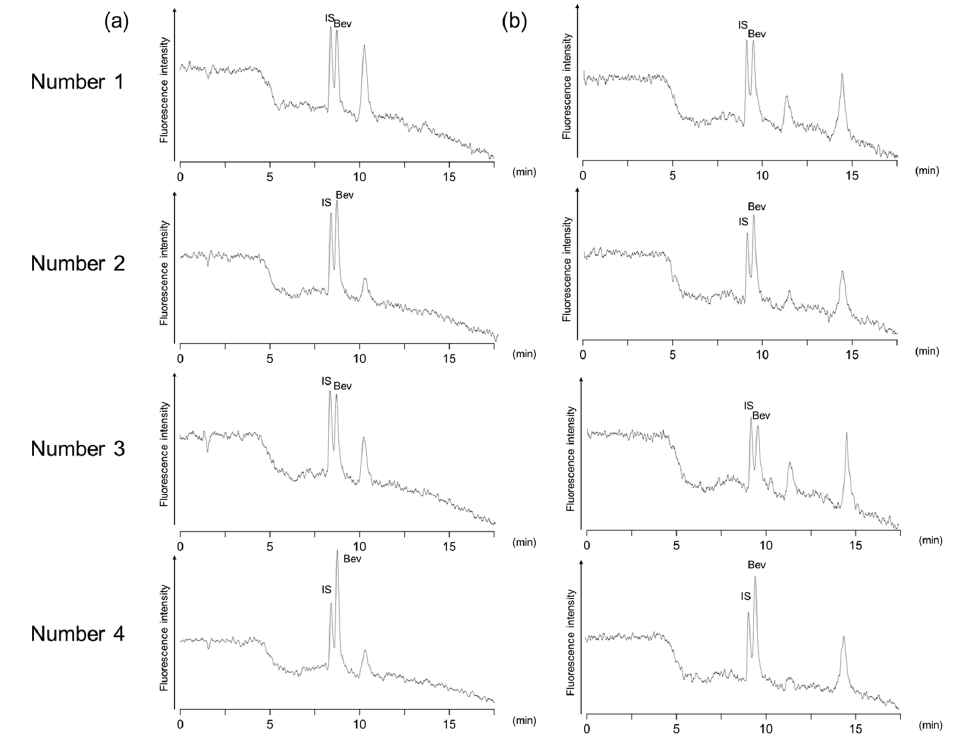
Figure 5. Chromatograms of plasma samples obtained from the patients with lung cancer that were administered bevacizumab with ( a ) aptamer affinity and ( b ) immune-affinity purification. Peaks: Bev: bevacizumab; IS: 20 µ g/mL trastuzumab. Sample dilution ratios prior to affinity purification were 20-fold except for Patient 4 (25-fold) in ( b ).